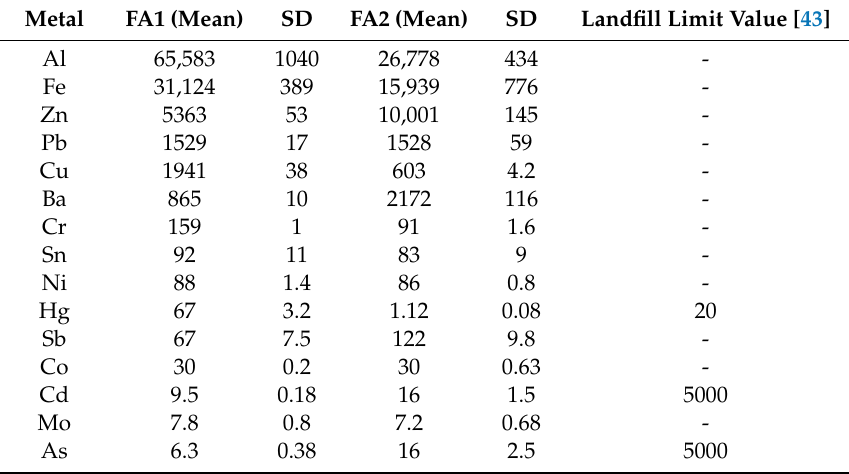
Table 4. Total heavy metal concentration in fly ash samples (mg / kg, dry weight